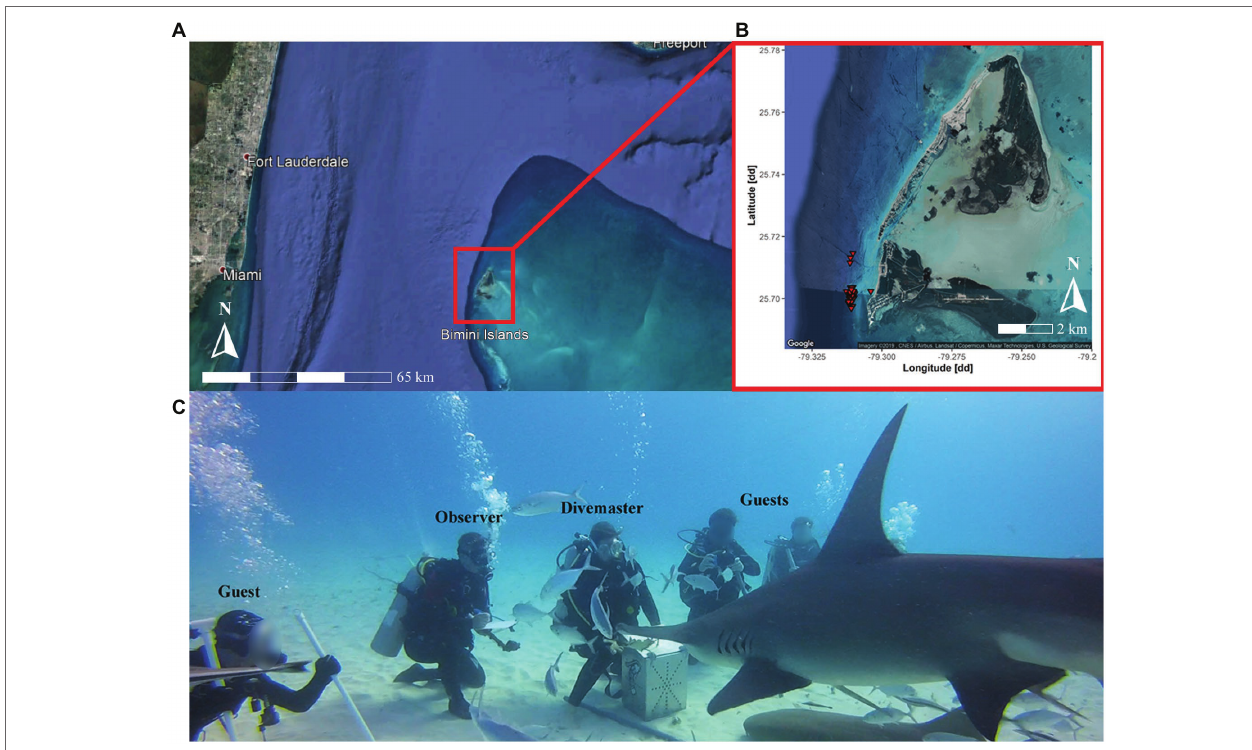
FIGURE 1 | Study site (A) , dive locations (B) , and underwater dive set-up (C) . The Bimini Islands are a group of islands on the western edge of the Great Bahama Bank that are approximately 85 km east of Miami (A) . The surveyed provisioning dives all took place on the west side of South Bimini (B) . The position of the observer combined with the underwater dive set-up used by the Neal Watson’s Bimini Scuba Center (NWBSC), allowed for a fast and reliable identification of individual sharks as well as quantification of the bait uptake (C) . Map generated using Google Earth (version 7.3.3.7786, accessed October 22nd 2020), SIO, NOAA, U.S. Navy, NGA, GEBCO. Insert generated using the “ggmap” package (Kahle and Wickham, 2013) in